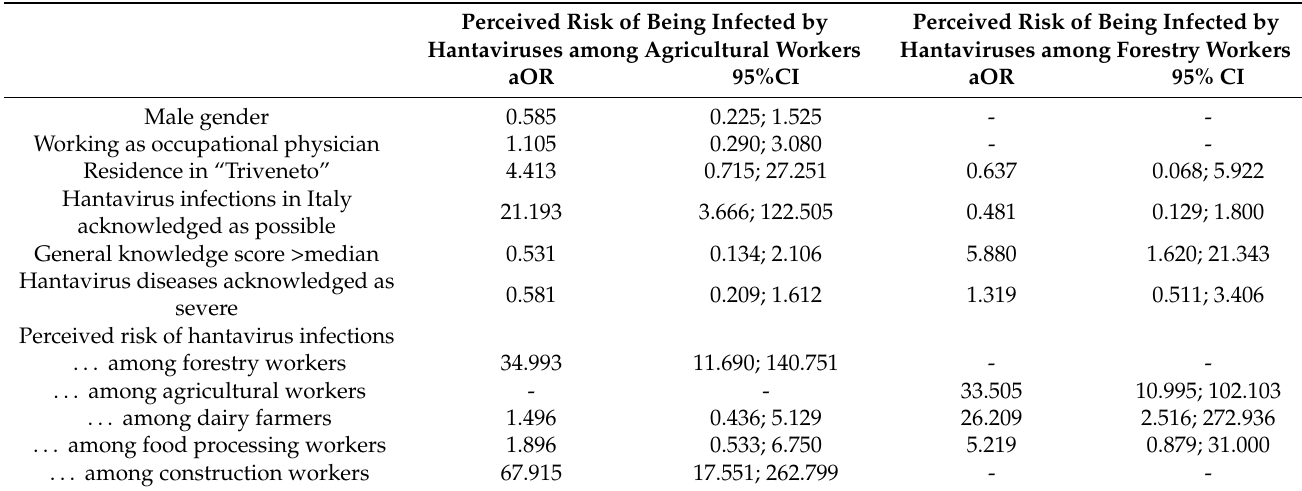
Table 5. Regression analysis of factors that in participating health care providers (No. = 223) were associated with higher risk perception for hantavirus infection of agricultural and forestry workers. Both models included as explanatory factors all dichotomous variables that in univariate analysis were associated with the outcome variables with p value < 0.25. Perceived Risk of Being Infected by Perceived Risk of Being Infected by Hantaviruses among Agricultural Workers Hantaviruses among Forestry Workers aOR